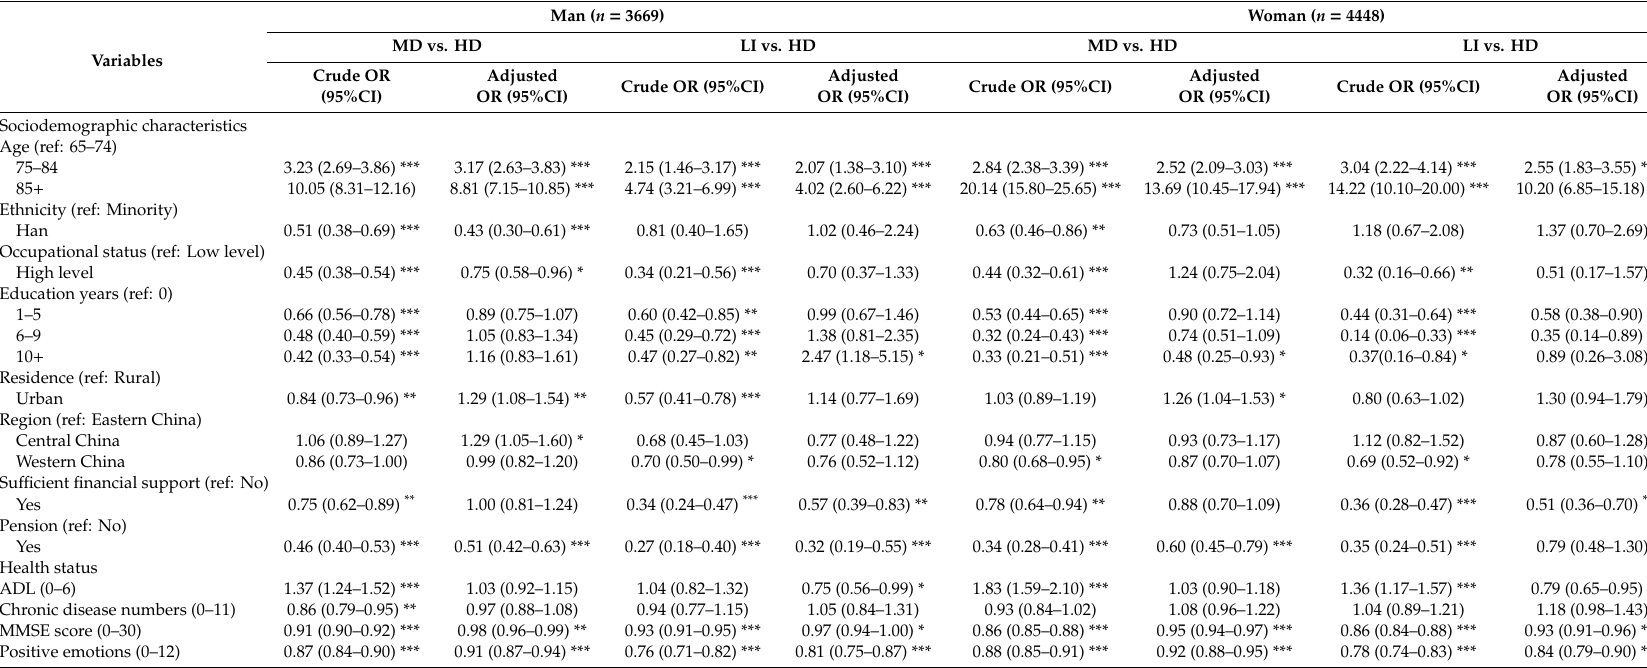
Table 4. Sex di ff erences in the associations between baseline characteristics and social engagement trajectory classes among older adults by univariable and multivariable logistic